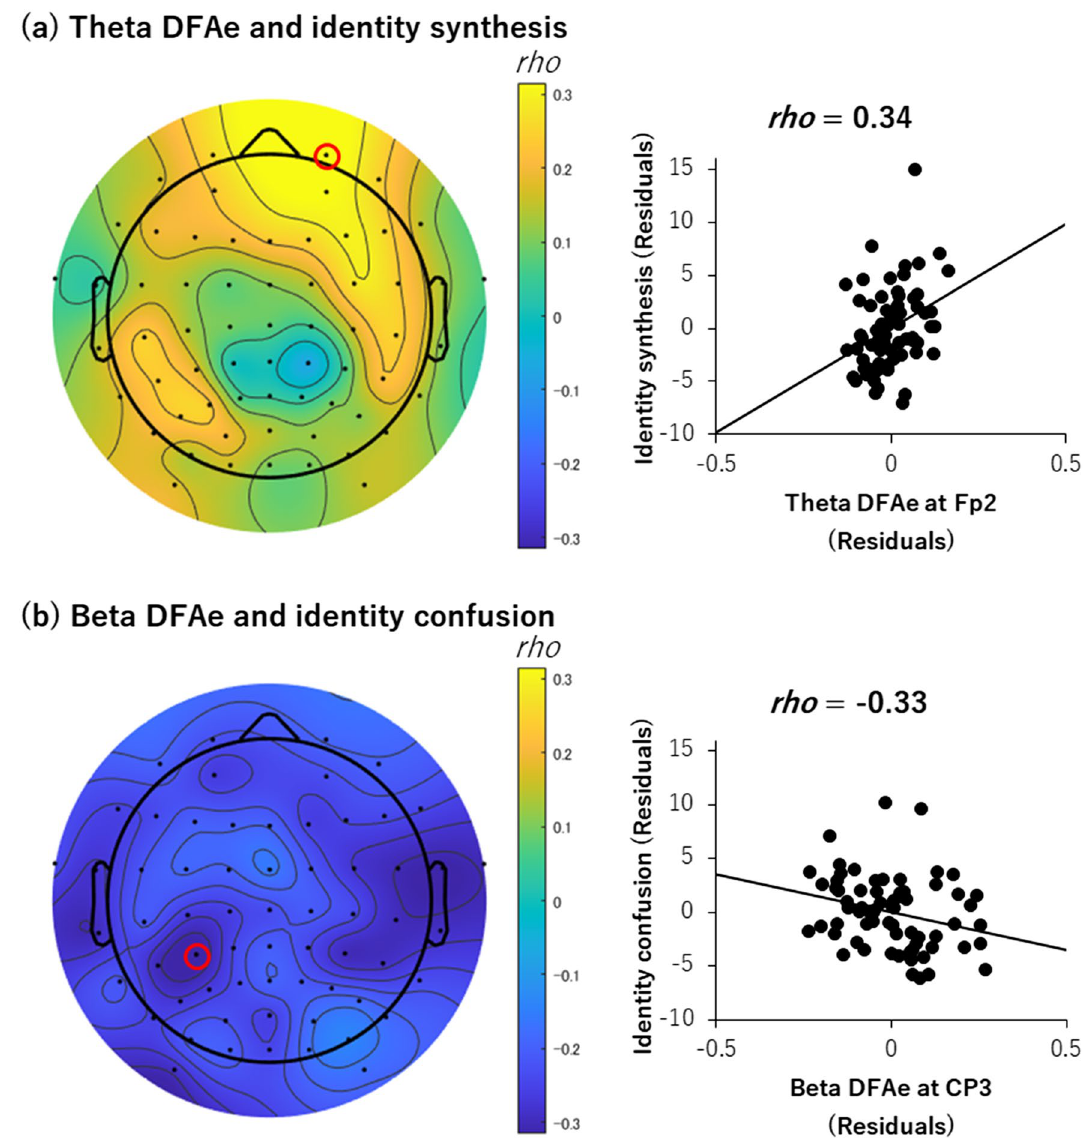
Figure 3. Topo maps and scatterplots of Spearman’s partial correlation analyses for descriptive purposes. ( a ) Correlation between theta range DFAe and identity synthesis. ( b ) Correlation between beta range DFAe and identity confusion. The red circle on each topo map indicates an electrode; the data from which is shown in the scatterplot. Topo maps were created by EEGLAB toolbox (ver.14.1.2b, https ://sccn.ucsd.edu/eegla b/index .php) 55